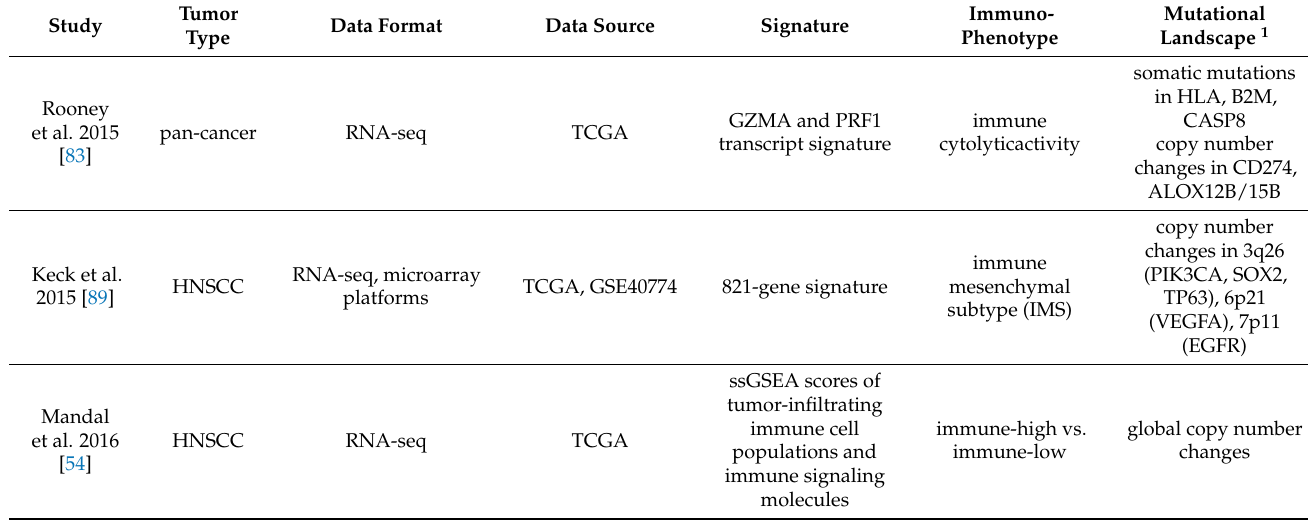
Table 1. Immune-related gene signatures in pan-cancer and HNSCC